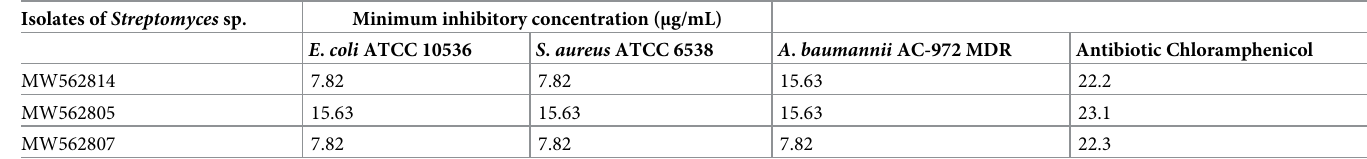
Table 3. Minimum inhibitory concentration of three Streptomyces sp. crude extracts, as determined by broth dilution method. Isolates of Streptomyces